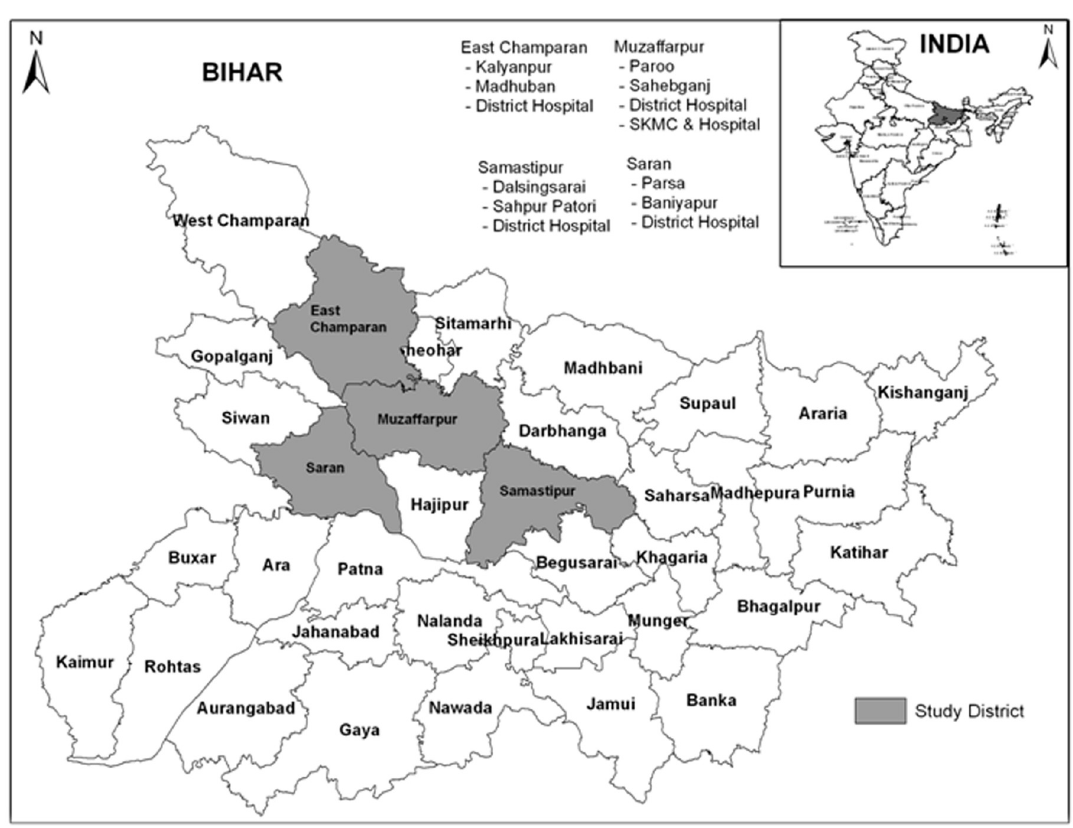
Fig 1. Location map of the study area (www.bihar.gov.in/http://www.maps of